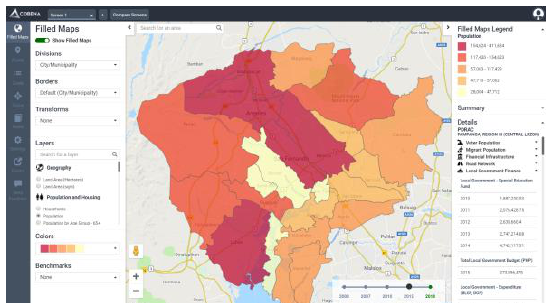
Figure 2. Snapshot: Choropleth of cities and municipalities filtered to a province, with area details summarized in the right sidebar.